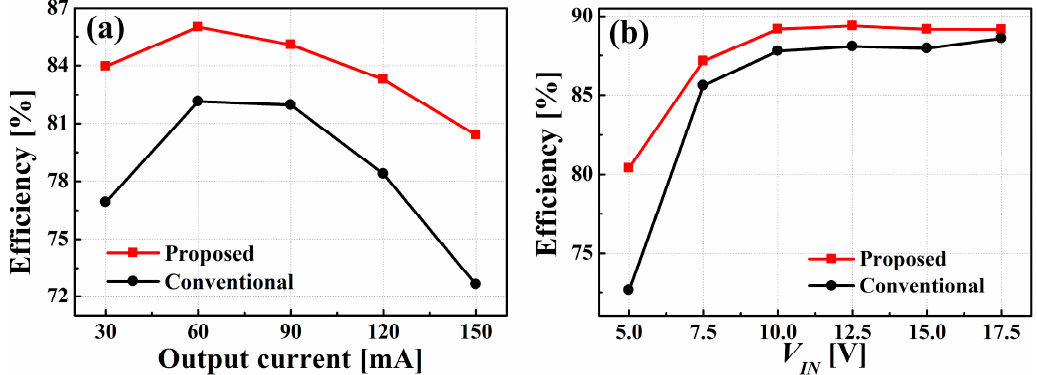
Figure 11. ( a ) η e versus I O at V IN = 5 V, V O = 40 V, f S = 1 MHz, and 30 ≤ I O ≤ 150 mA. ( b ) η e versus V IN at I O = 150 mA , V O = 40 V, f S = 1 MHz, and 5 ≤ V IN ≤ 17.5 V.